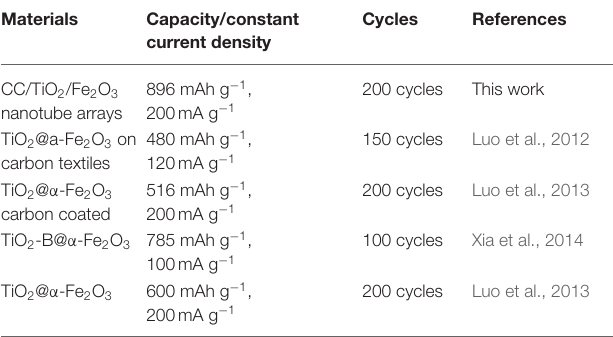
TABLE 1 | List of research reports on TiO 2 /Fe 2 O 3 as lithium-ion anodes. Materials Capacity/constant current